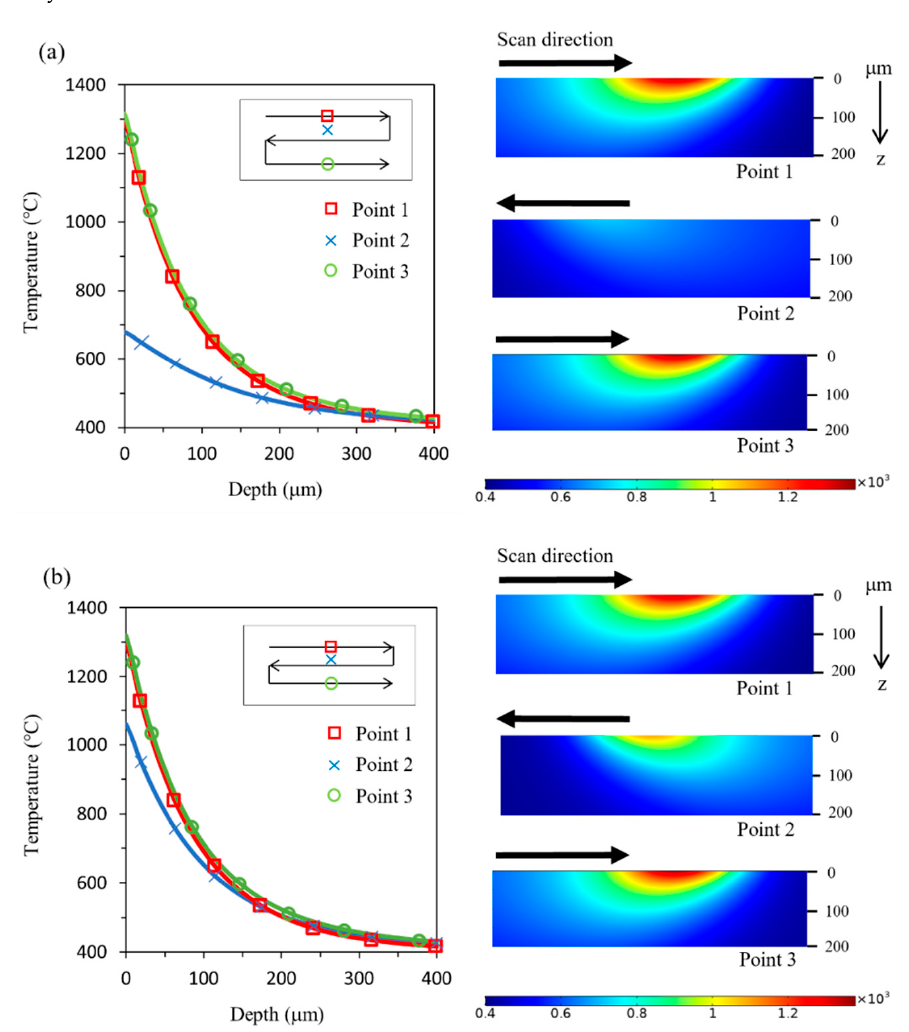
Figure 5. Temperature distribution along the depth direction: ( a ) test 1 and ( b ) test 2.